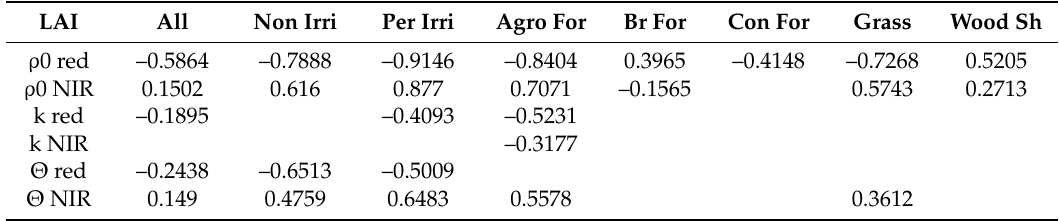
Table 5. Spearman correlation coefficient from the LAI and each of the MRPV parameters. In the second column, the Rho’s from all seven MISR orbit pixels is shown. Missing cells indicate non-significant Spearman correlation. The Non Irri-Wood Sh are the abbreviations to the CLC